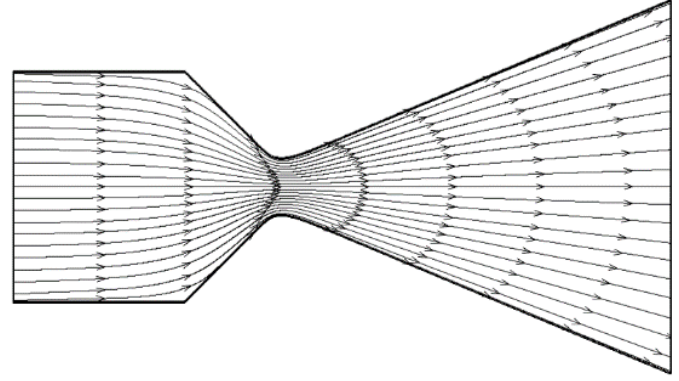
Figure 11. The streamline in a fully expanded micronozzle.